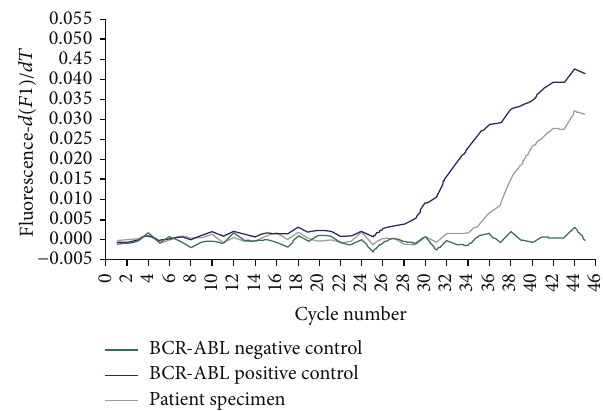
Figure 2: BCR-ABL1 qualitative RT-PCR amplification curves. Lightcycler amplification curves showing the cycle number of the crossing point (CP), the point where the reaction’s fluorescence reaches the maximum of the second derivative of the amplification curve corresponding to the point where the acceleration of the fluorescence signal is at its maximum. The CP is 29 cycles for the positive control (purple), 35 cycles for the patient’s peripheral blood specimen (grey), and no amplification for the negative control (no DNA) (green). Thus, the BCR-ABL1 fusion transcript was detected from the patient’s peripheral